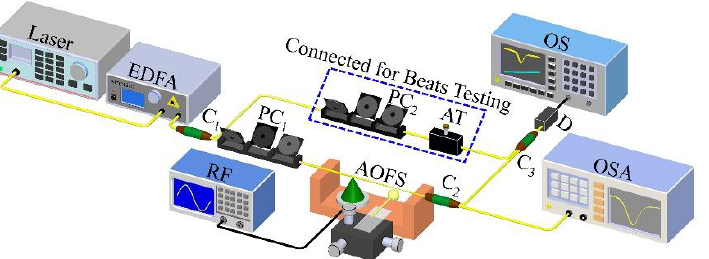
Figure 2. Experimental configuration to demonstrate the proposed AOFS. EDFA: erbium-doped fiber amplifier; RF: radio frequency generator; PC 1 and PC 2 : polarization controllers; AT: attenuator; D: optical detector; OS: oscilloscope; OSA: optical spectral analyzer; C 1 , C 2 and C 3 : couplers.